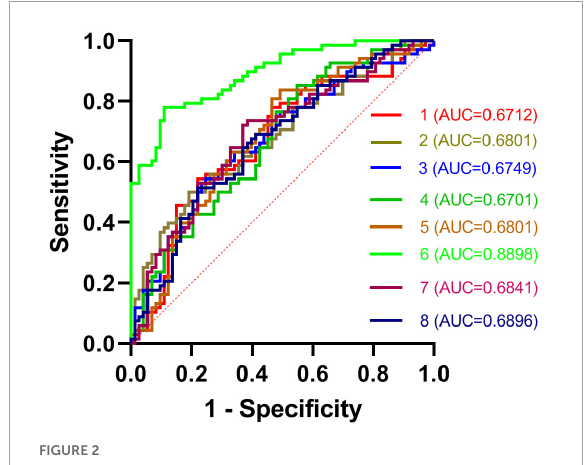
FIGURE2 ROC curves for the differentiation between TLE patients and HCs based on DC values in abnormal brain regions. TLE, temporal lobe epilepsy; ROC, receiver operating characteristic; HCs, healthy controls; and DC, degree